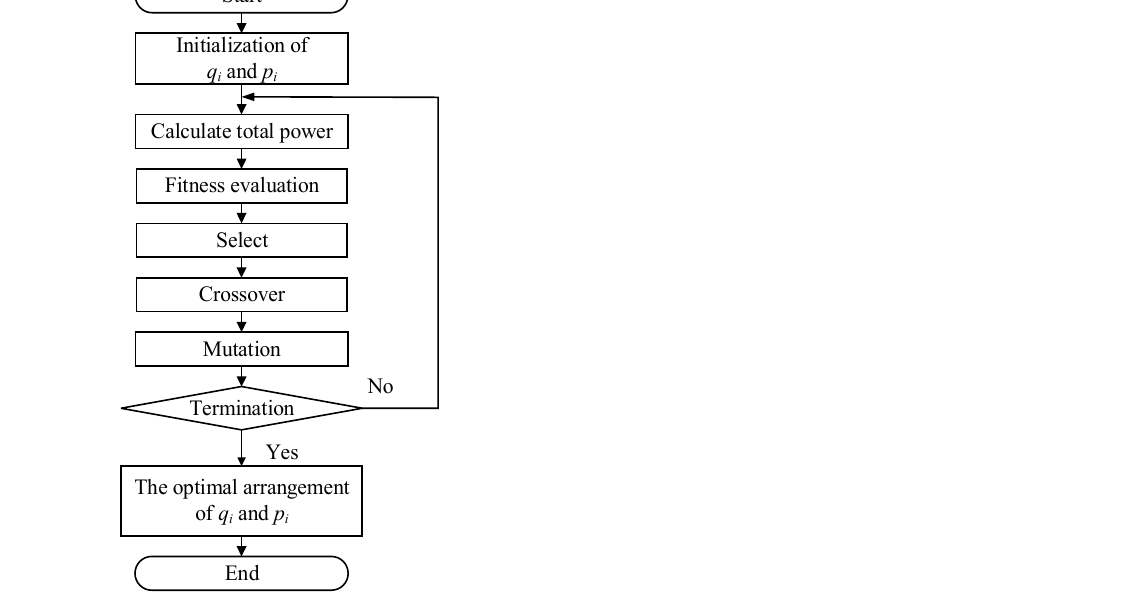
Table 1. Main parameters of the genetic algorithm.